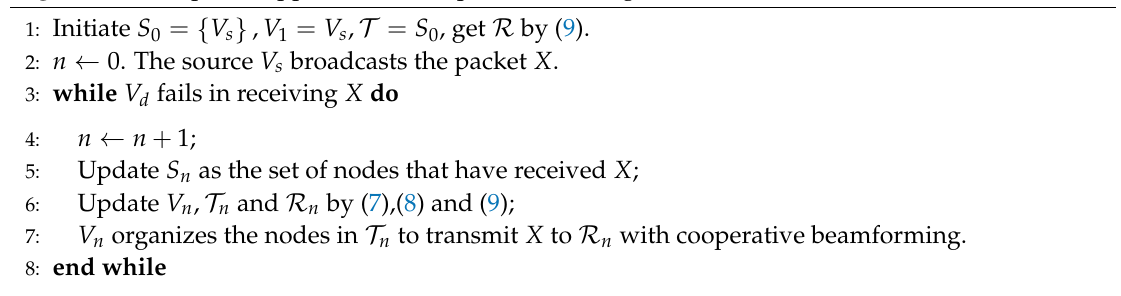
Algorithm 1 Proposed opportunistic cooperative routing